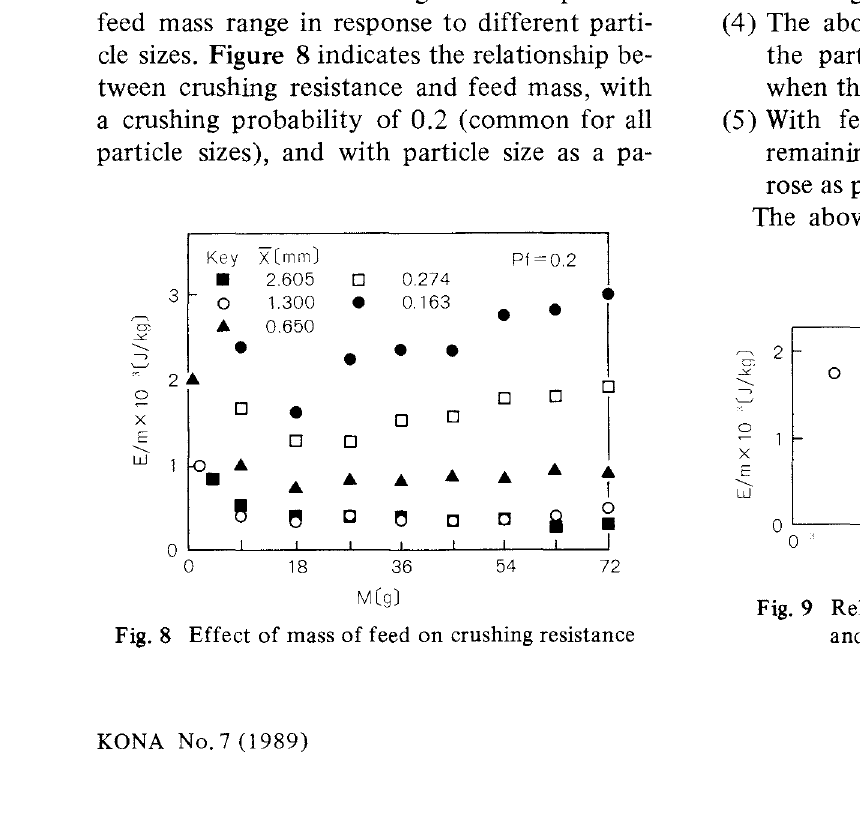
Fig. 8 Effect of mass of feed on crushing resistance